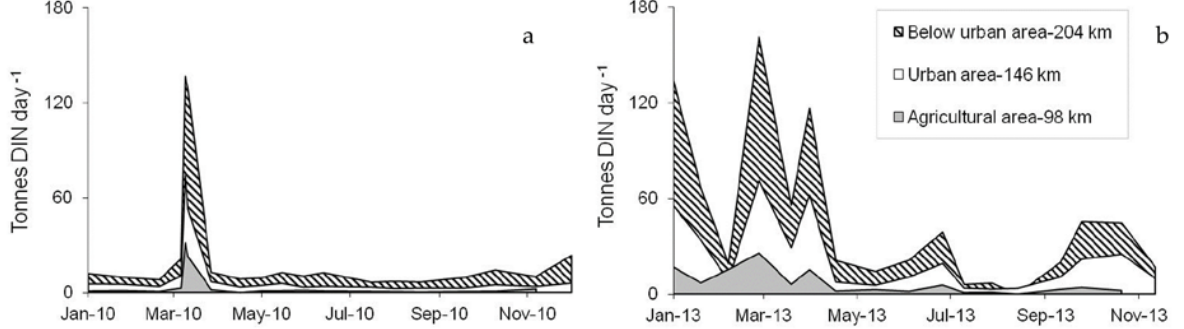
Figure 6. Dissolved inorganic nitrogen loads (tonnes DIN per day) in three sections of the Central Grand River in 2010 ( a ) and 2013 ( b ). Agricultural area-West Montrose (02GA034); Urban Area–Blair (02GA048); Below urban area–Brantford (02GB001). Discharge data obtained from Water Survey Canada and GRCA. Distance in kilometers from headwaters.